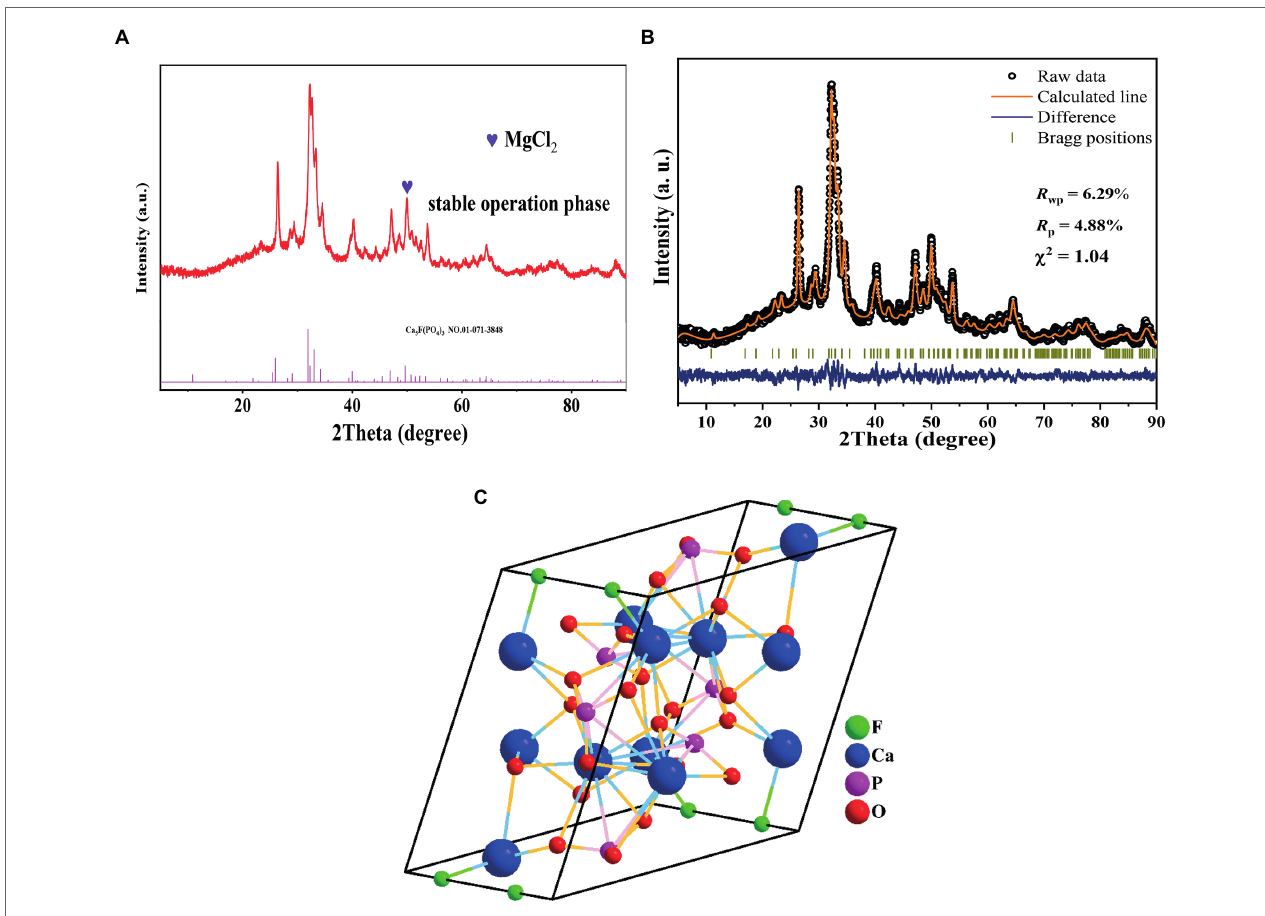
FIGURE 9 | (A) X-ray diffraction (XRD) analysis of polyvinyl chloride (PVC) membrane sample surface during stable operation. (B) XRD refinement of PVC membrane sample surfaces during stable operation. (C) Crystal structure of Ca 5 F(PO 4 ) 3